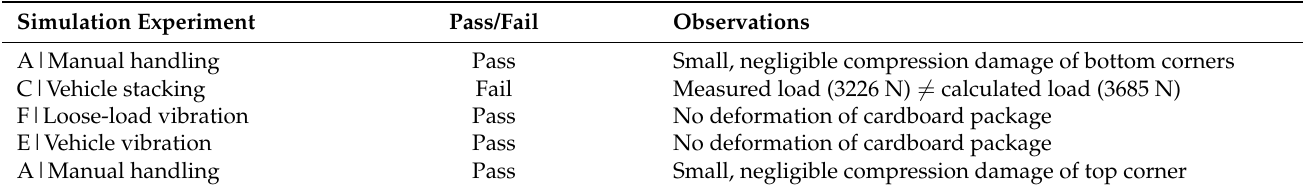
Table 2. Outcome of transport simulation test cycle of the tripartite cardboard box (ASTM D4169 DC13). Simulation Experiment